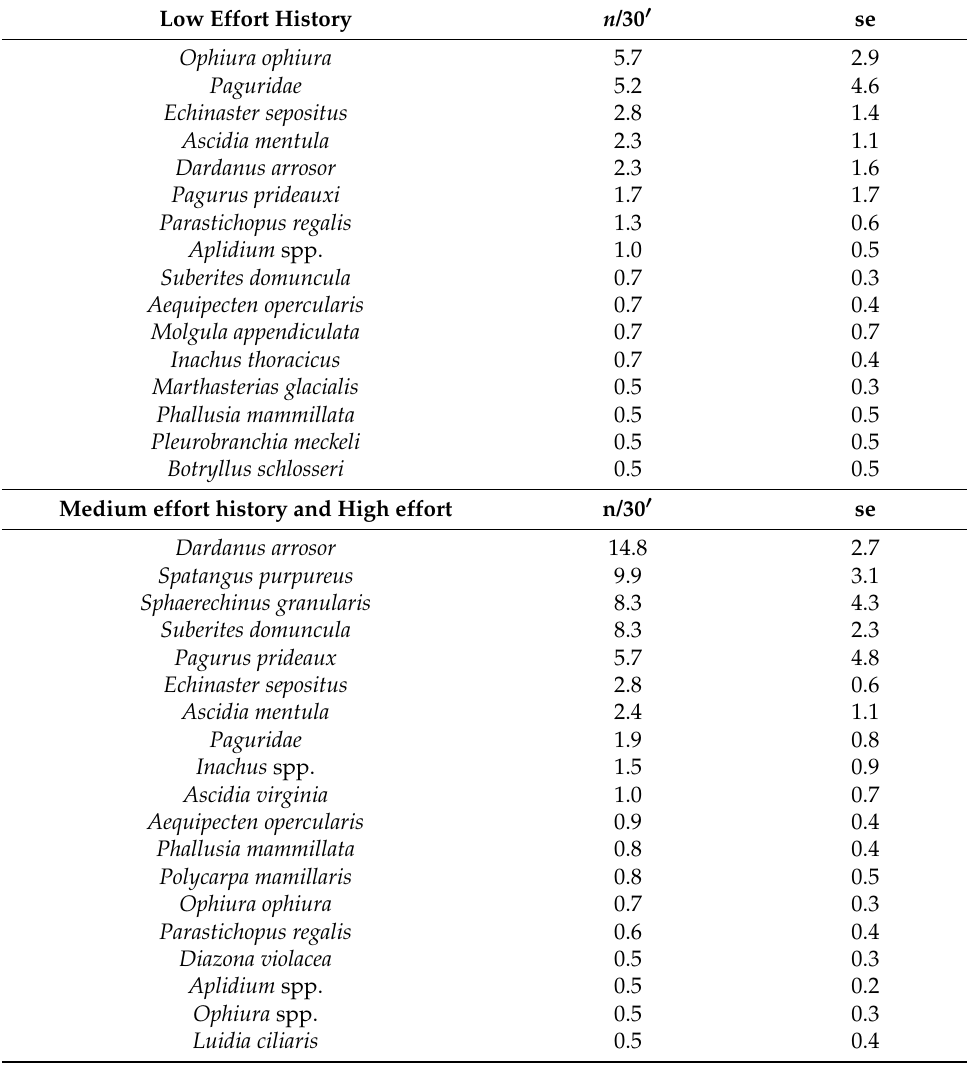
Table 4. Average values of abundance, in terms of individuals ( n ) per 30 min of fishing, of the main epibenthic species caught in commercial hauls, estimated from the sampling of scientific observers on board the trawling fleet in the Low effort history area, as well as in the Medium effort history and High effort areas, considered in the present